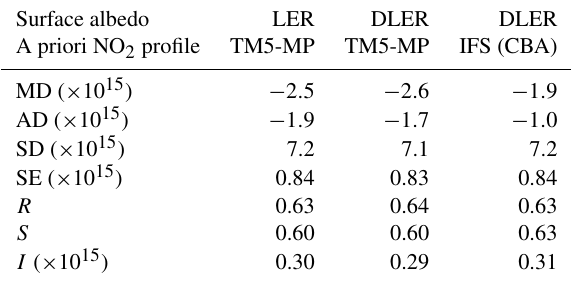
Table 4. The mean difference (MD) and median difference (AD) (SAT-GB in 10 15 molec.cm − 2 ), standard deviation (SD, in 10 15 molec.cm − 2 ), standard error of the mean (SE, in 10 15 molec.cm − 2 ), and correlation coefficient R , slope S , and in- tercept I (in 10 15 molec.cm − 2 ) of the orthogonal regression for the daily GOME-2 tropospheric NO 2 product compared to MAXDOAS data at Xianghe. Intermediate results for different surface albedo and a priori NO 2 profiles are reported for completely clear-sky con- ditions (a cloud radiance fraction of 0) for a total of 73 GOME-2 pixels.